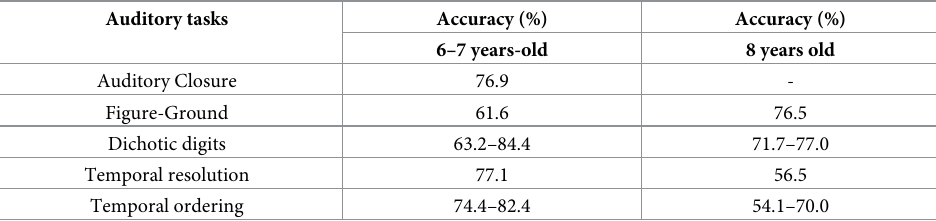
Table 5. CAP screening protocol recommended for schoolchildren in the 6- to 8-year-old age